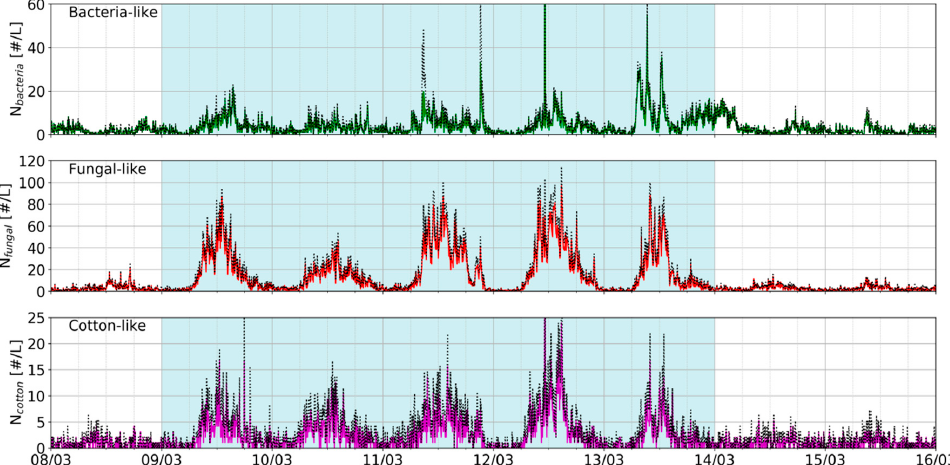
Figure 7. Time series of broad class number concentrations for the entire measurement period (5 min integrations). Top: Bacteria-like; Middle: fungal-like; Bottom: cotton-like. Solid line denotes an assignment probability p > 0.9; dashed line p > 0.75. Blue shaded area indicates weekdays.